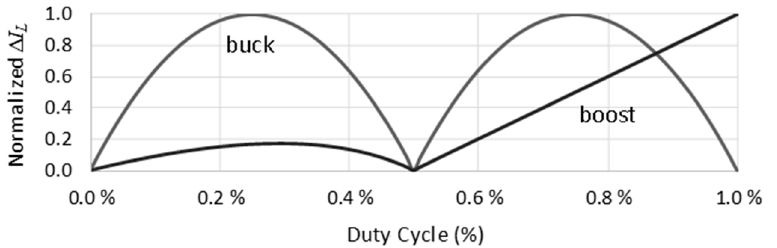
Figure 4. Correlation between the duty cycle and the normalized current ripple for the inductor of the bidirectional multilevel dc–dc power converter, considering the buck mode and boost